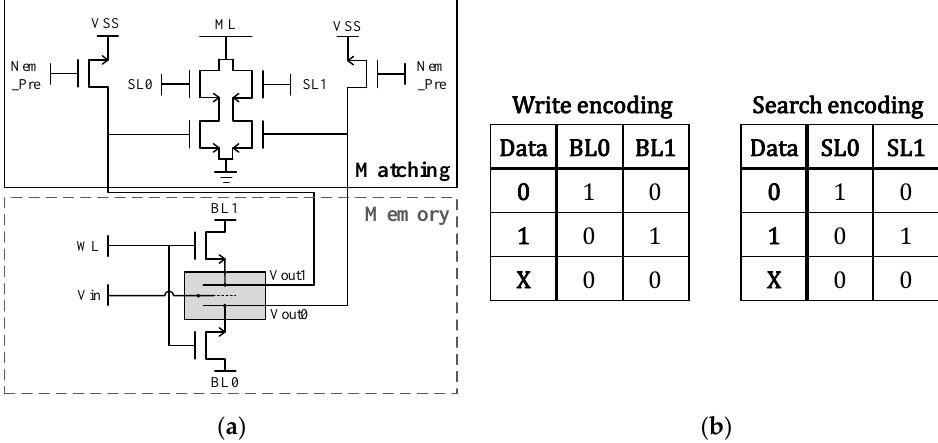
Figure 9. Schematic design of ( a ) NEM-based CAM cell; and ( b ) data encodings for write and search.